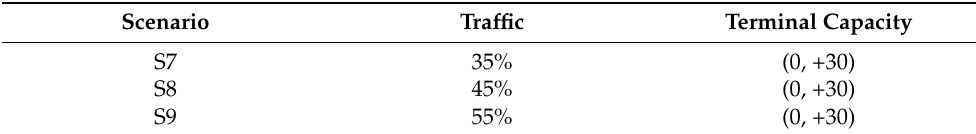
Table 5. Additional scenarios based on the increase of the ground delay range.